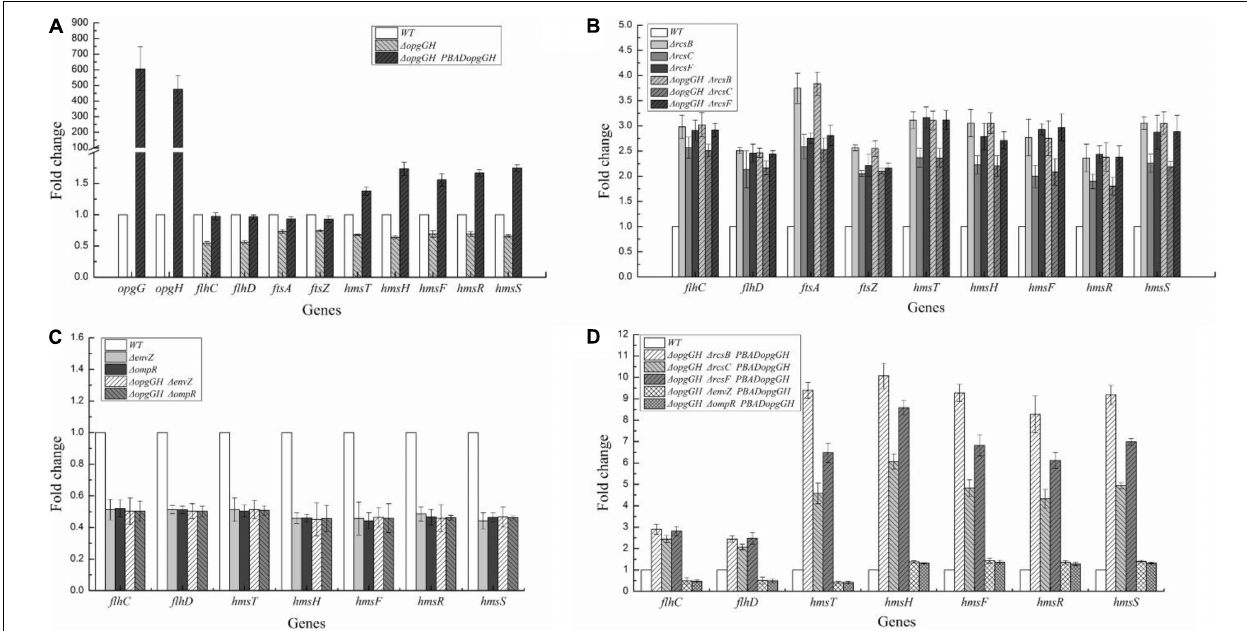
FIGURE 7 | Transcriptional changes in the mutant strains of Y. enterocolitica . Y. enterocolitica grown to the mid-log phase in LNNS medium and total RNA was extracted. Expression of opgGH , flhDC , ftsAZ , hmsHFRS, and hmsT were determined by RT-qPCR in vitro . The 16S rRNA gene was used as a normalization control. (A) Gene transcription in (cid:49) opgGH and (cid:49) opgGH -P BAD opgGH strains. (B) Gene transcription in (cid:49) rcsF , (cid:49) rcsC , (cid:49) rcsB , (cid:49) opgGH- (cid:49) rcsF , (cid:49) opgGH- (cid:49) rcsC, and (cid:49) opgGH- (cid:49) rcsB mutant strains. (C) Gene transcription in (cid:49) envZ , (cid:49) ompR , (cid:49) opgGH- (cid:49) envZ, and (cid:49) opgGH- (cid:49) ompR mutant strains. (D) Gene transcription